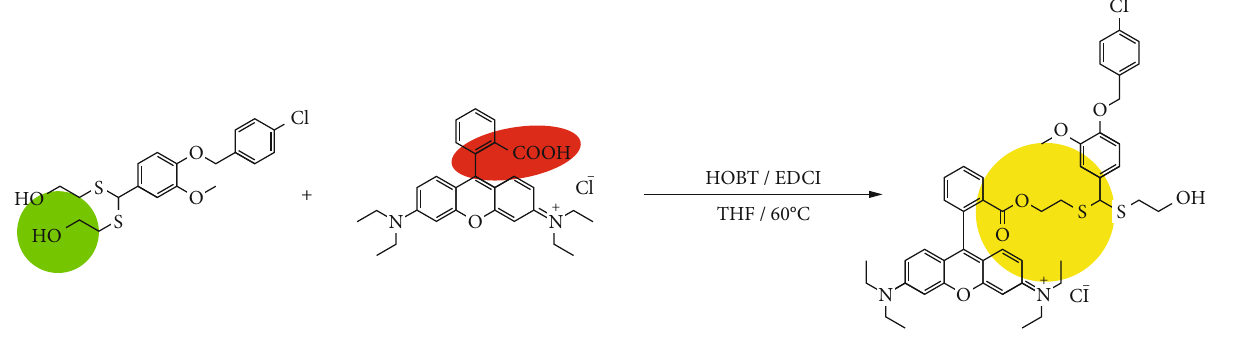
Figure 2: Synthetic route of vanisulfane with fl uorescent label. Table 1: Experiments of adding and recovering vanisulfane in tobacco root, stem leaf.